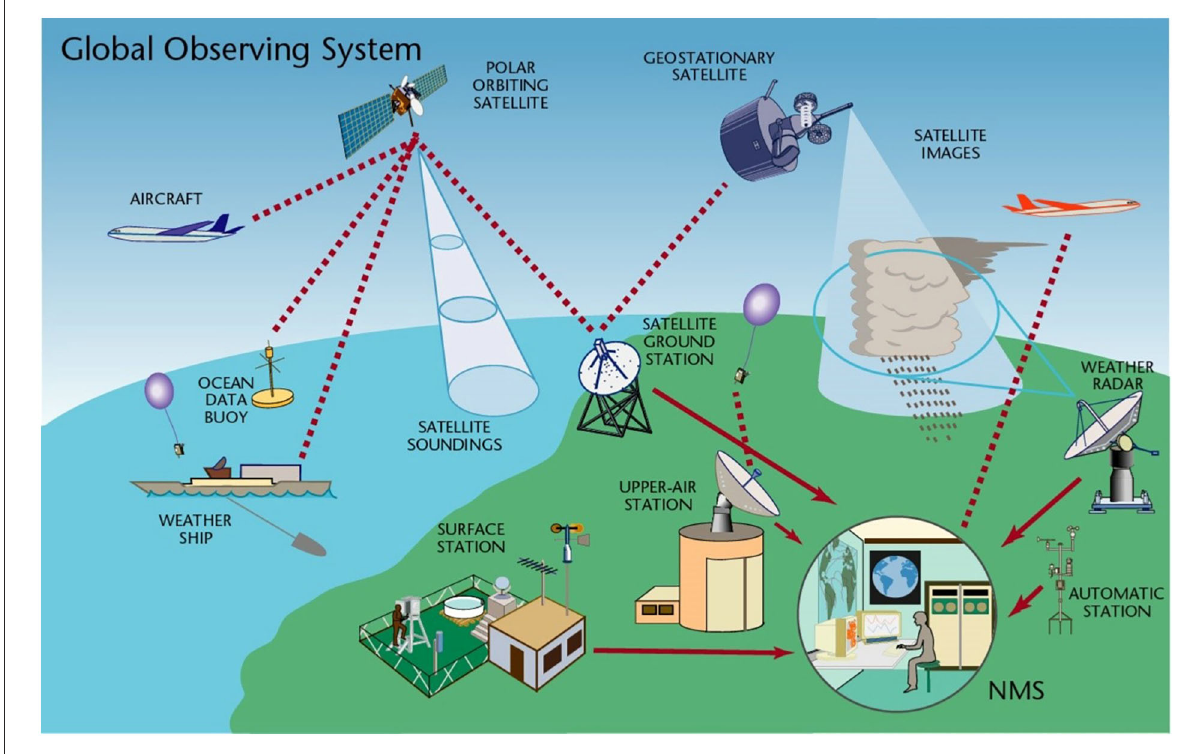
FIGURE5 Analysis of multi-source remote sensing data (Robert FitzRoy,